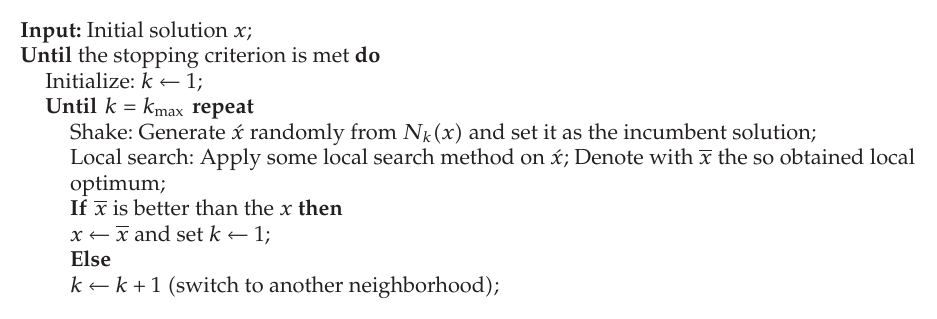
Algorithm 2: Outline of the basic variable neighborhood search.